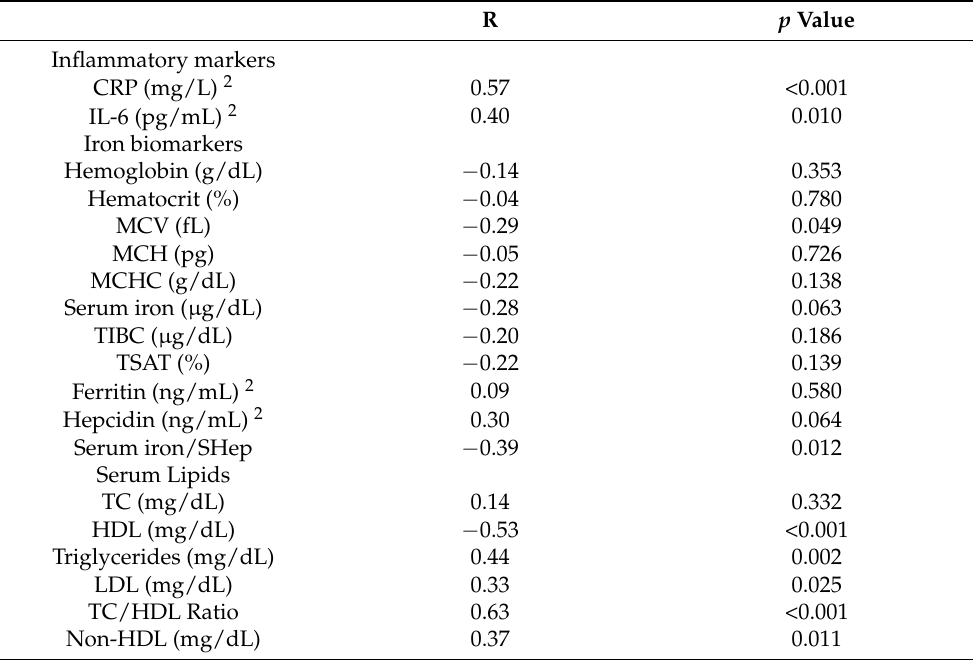
Table 3. Correlation of BMI with inflammatory markers, iron status, and serum lipid concentrations in healthy young women ( n = 47) 1 .